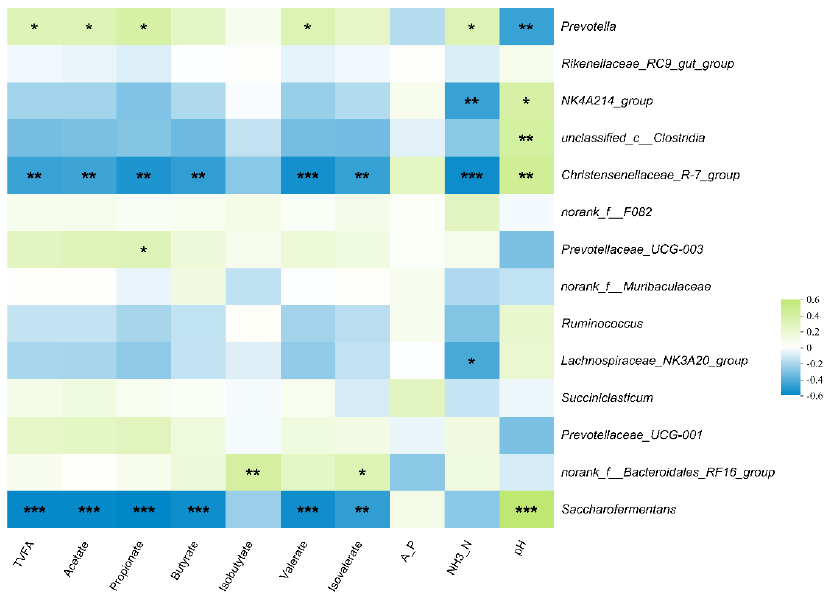
Figure 3. Heat map of correlations between rumen bacteria and rumen fermentation parameters.